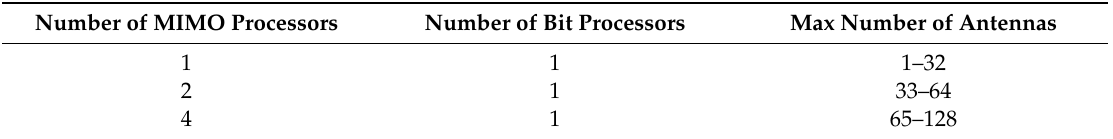
Table 1. MU-MIMO System Configurations.